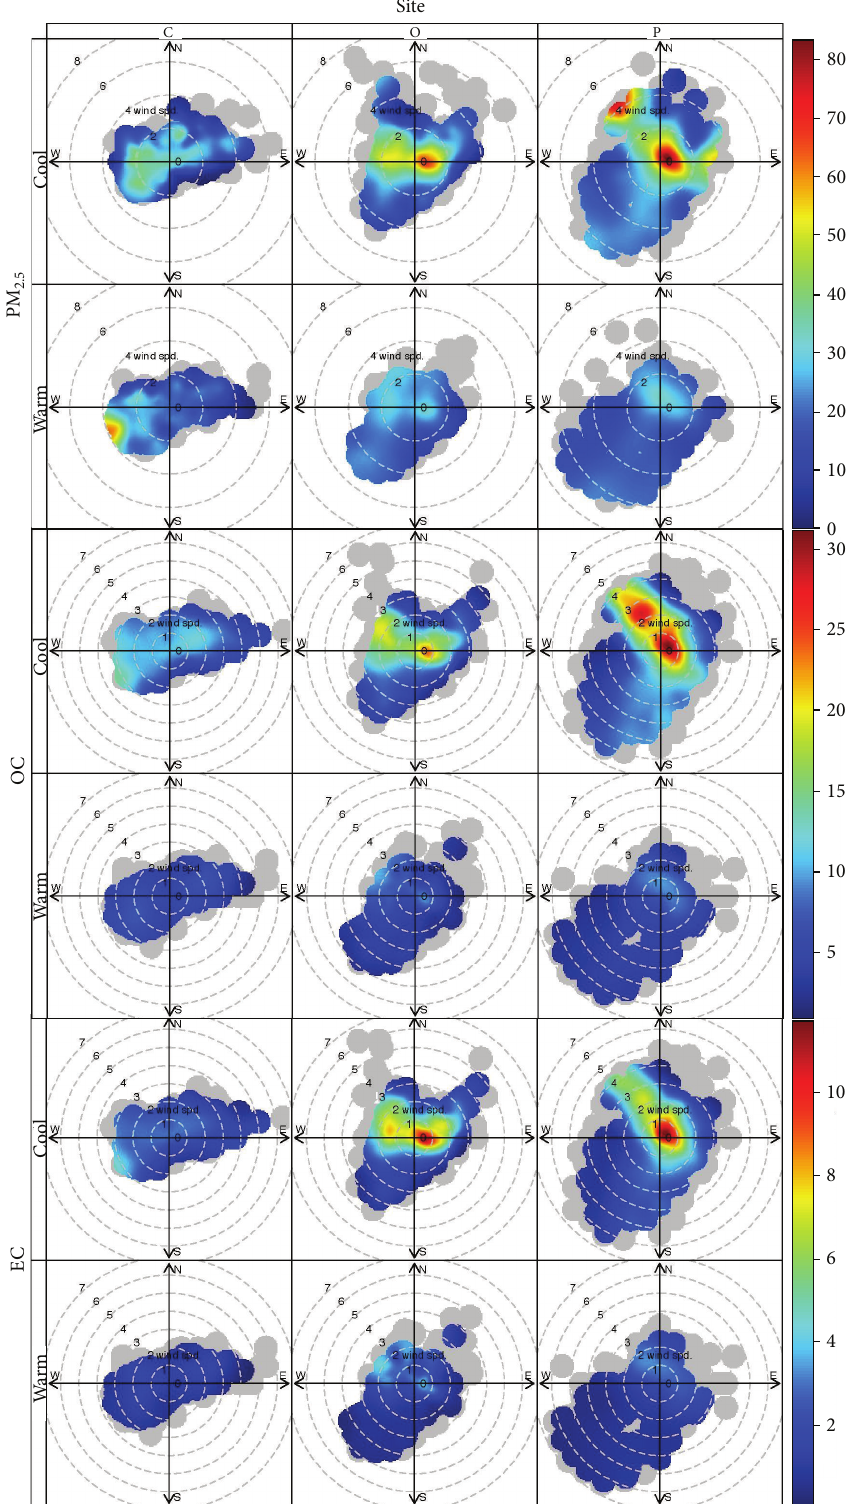
Figure 4: Bivariate polar plot for the mean concentration of PM 2.5 , OC, and EC for the sites under study in cold (winter and fall seasons) and warm periods (summer and spring seasons). Label of the stations in Figure 1. Las Condes: C Label, P. O’Higgins: O Label, and Pudahuel: P